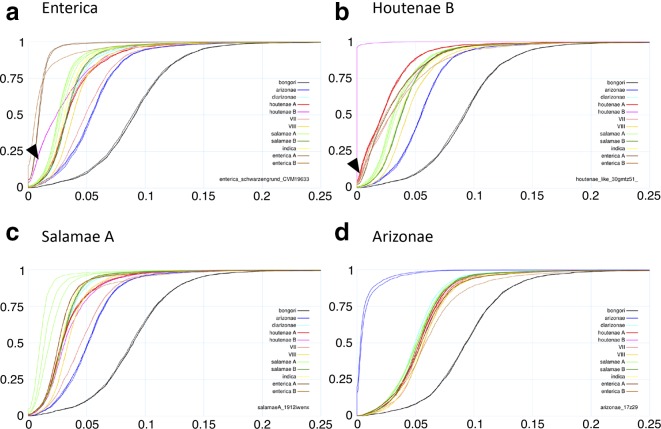
Cumulative curves of gene-by-gene distances between selected pairs of genomes. (a) Comparisons with Enterica (group B, serovar Schwartzengrund CVM19633). The arrowhead shows that 20 % (0.20, y-axis) of the genes of an Enterica B strain have less than 1 % (0.01, x-axis) divergence to Houtenae B. (b) Comparisons with Houtenae B (2193/78). The arrowhead shows that 5 % of the VII genome and 6 % of Houtenae A have less than 0.1 % divergence with Houtenae B. (c) Comparisons with Salamae A (1268/72). (d) Comparisons with Arizonae (CDC 129–73).